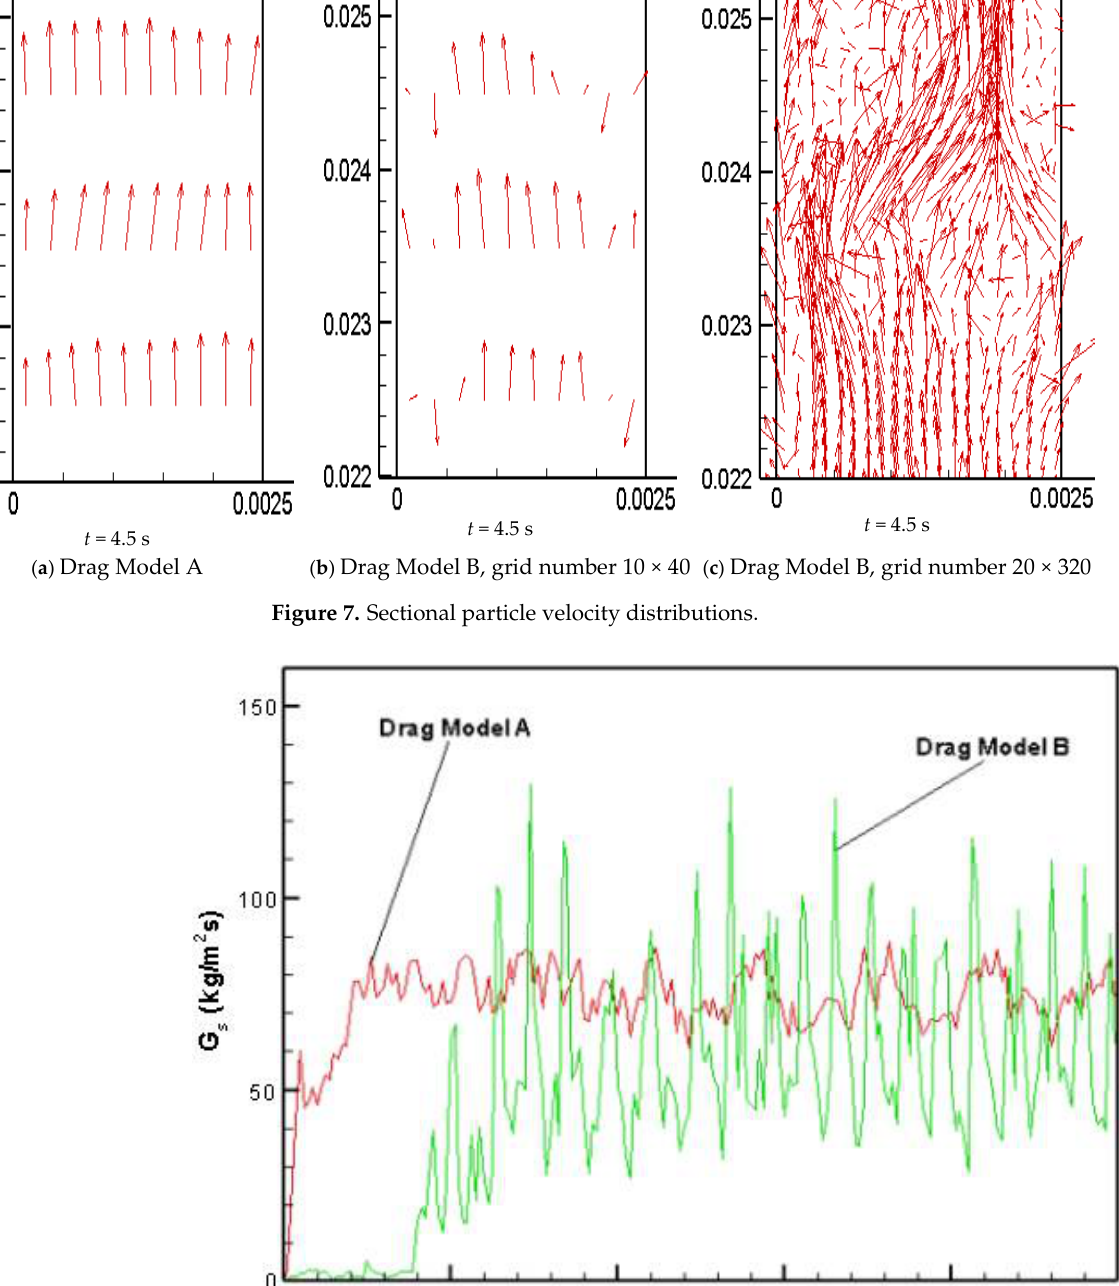
Figure 8. Outlet solid flux: drag Models A and B both with grid number 10 × 40.